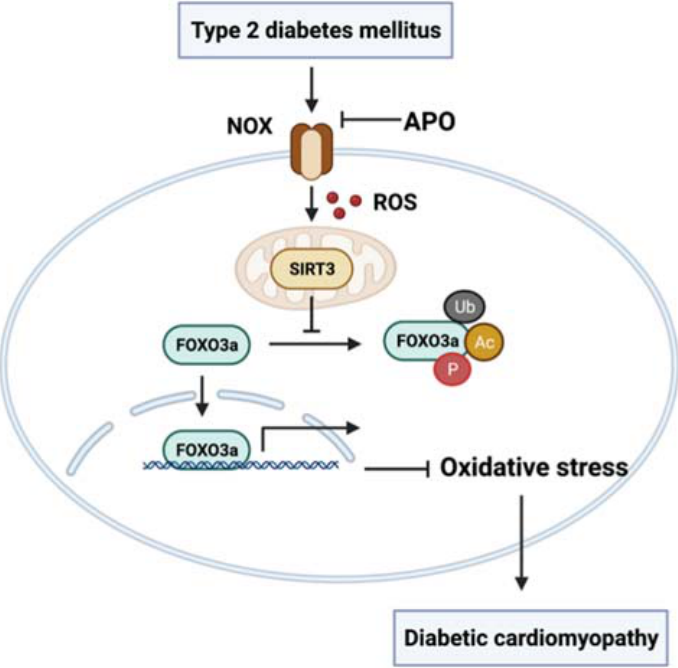
Figure 6. Within diabetic ventricles, NADPH oxidase (NOX) is an enzyme that plays a significant part in the development of oxidative stress. Apocynin (APO) can improve myocardial reactive oxygen species (ROS) overproduction and mitochondrial function through recovery of the SIRT3/FOXO3a pathway, thereby reducing the incidence of diabetic cardiomyopathy. It is possible that this substance will be developed into a medication for use in the clinical management of diabetic ventricular remodeling.